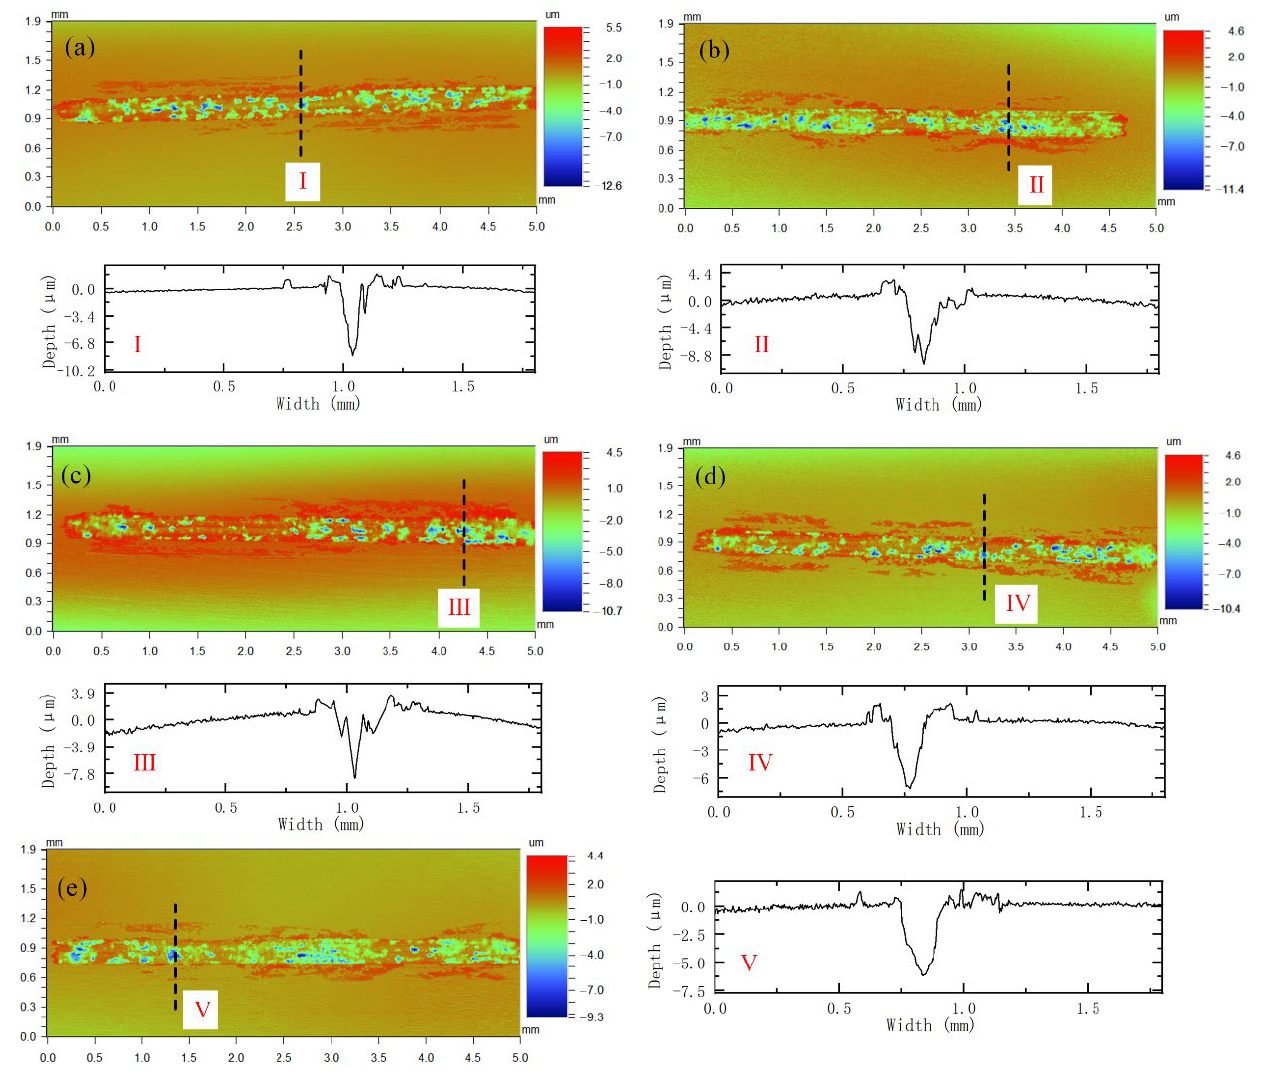
Figure 10. Surface topography and the cross section of the wear tracks ( a ) Specimen-0, ( b ) Specimen-1, ( c ) Specimen-2, ( d ) Specimen-3, ( e ) Specimen-4.